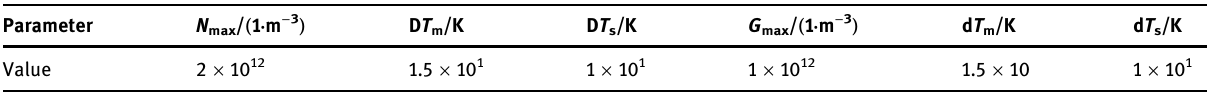
Table 3: Parameters of mathematical model